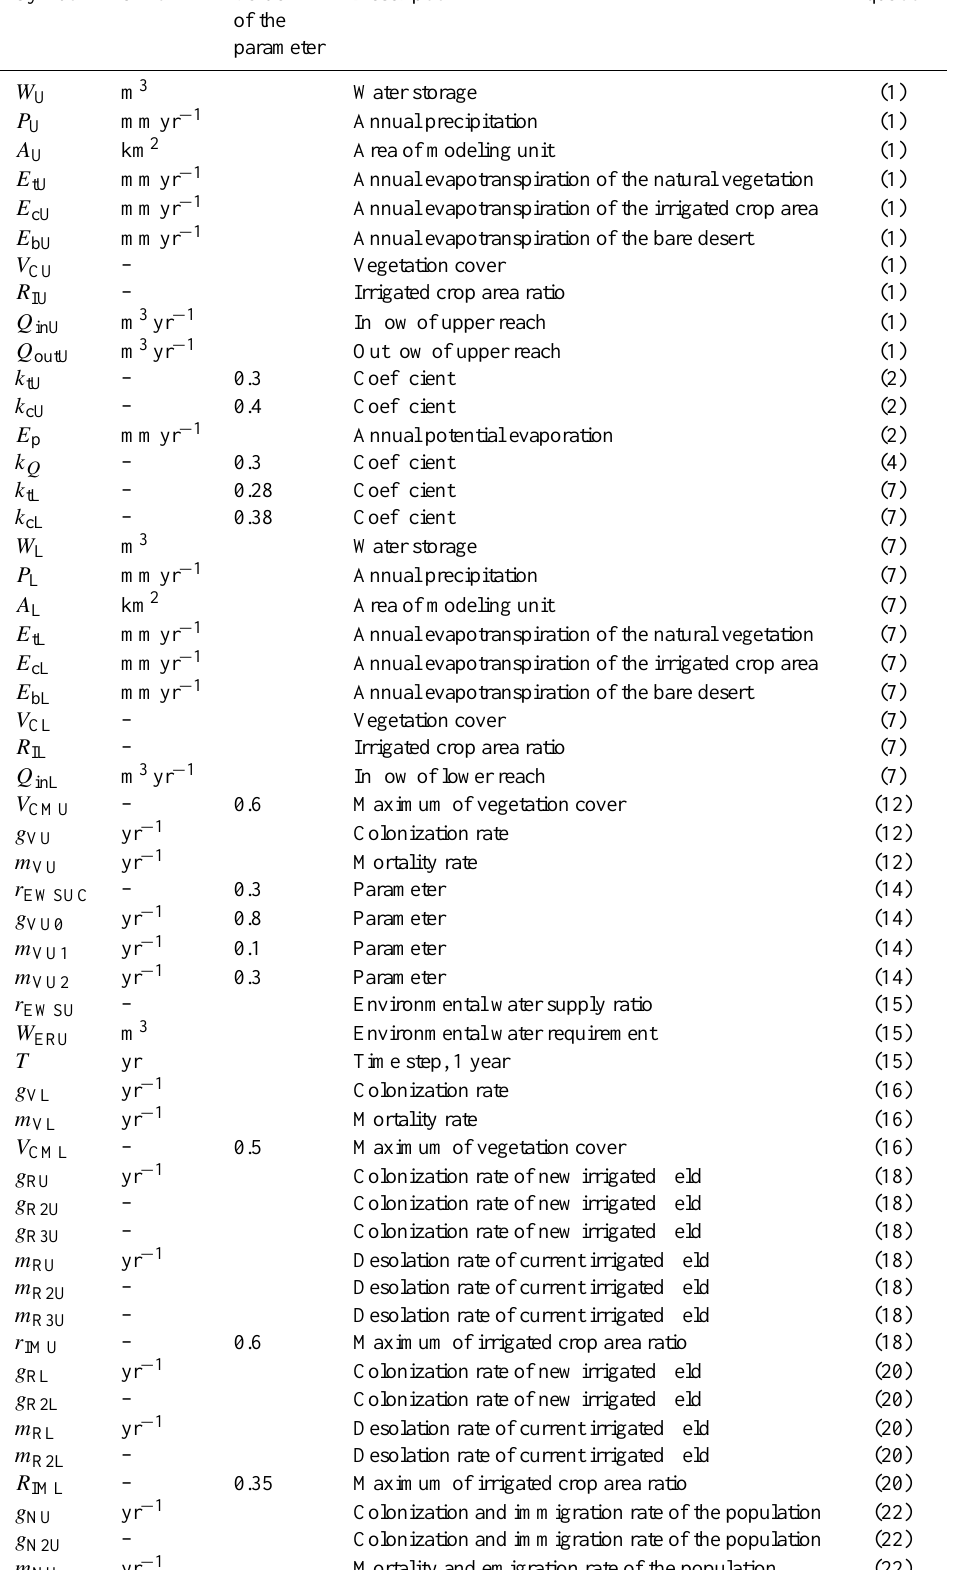
Table A1. Nomenclature: the subscript “U” represents the upper reach, and the subscript “L” represents the lower reach. Symbol